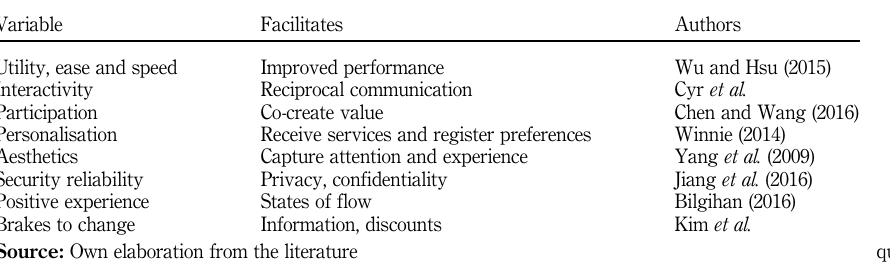
Table I. Variables related